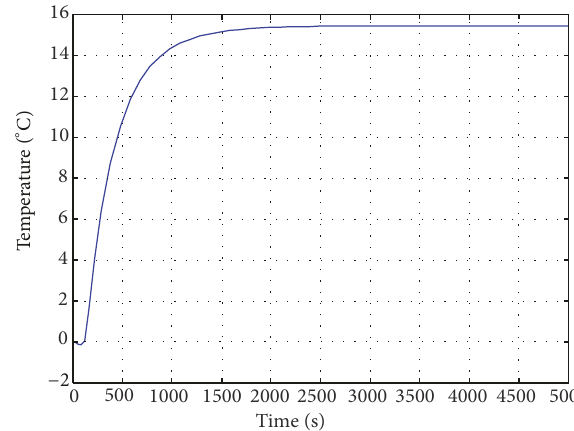
Figure 4: The variation curve of 𝑦 1 when the load of generator unit is 400MW, 𝑢 𝑗 ∈ [0,12] , and the increment of 𝑢 2 is 4.